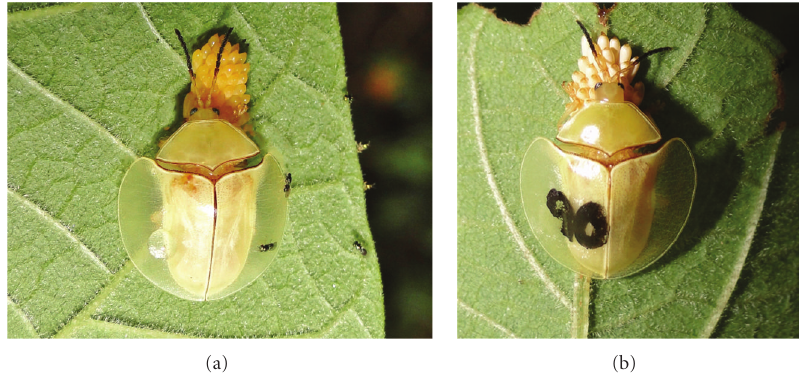
Figure 2: Omaspides pallidipennis Boheman, 1854 (Chrysomelidae) female (a) on recently laid egg cluster (b) after a few days. A fragment of Atlantic Forest (Floresta Nacional de Passa Quatro, Minas Gerais State, Brazil).